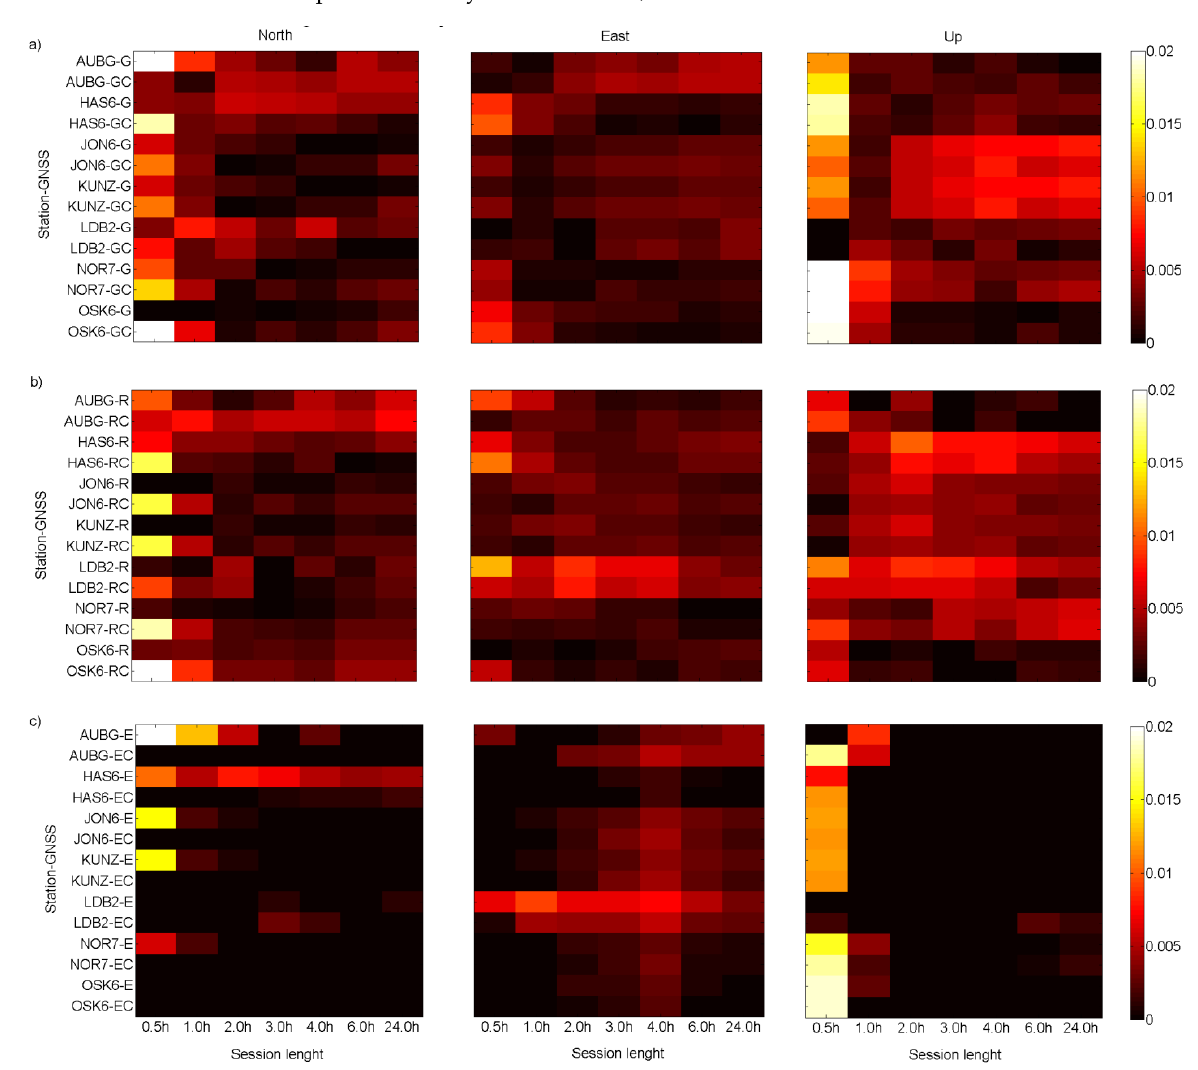
Figure 2. Absolute value of mean NEU components differences (in meters) for scenarios: ( a ) I, ( b ) II, Figure 2 . Absolute value of mean NEU components differences (in meters) for scenarios: a ) I, b ) II, ( c ) c ) III.